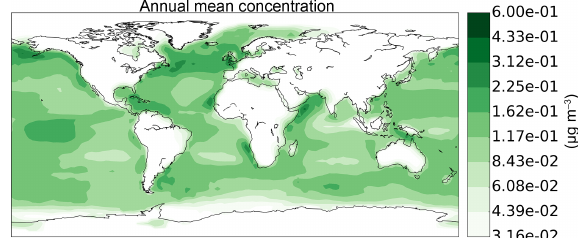
Figure 2. Annual mean modelled mass concentration of submicron marine organic aerosol at surface